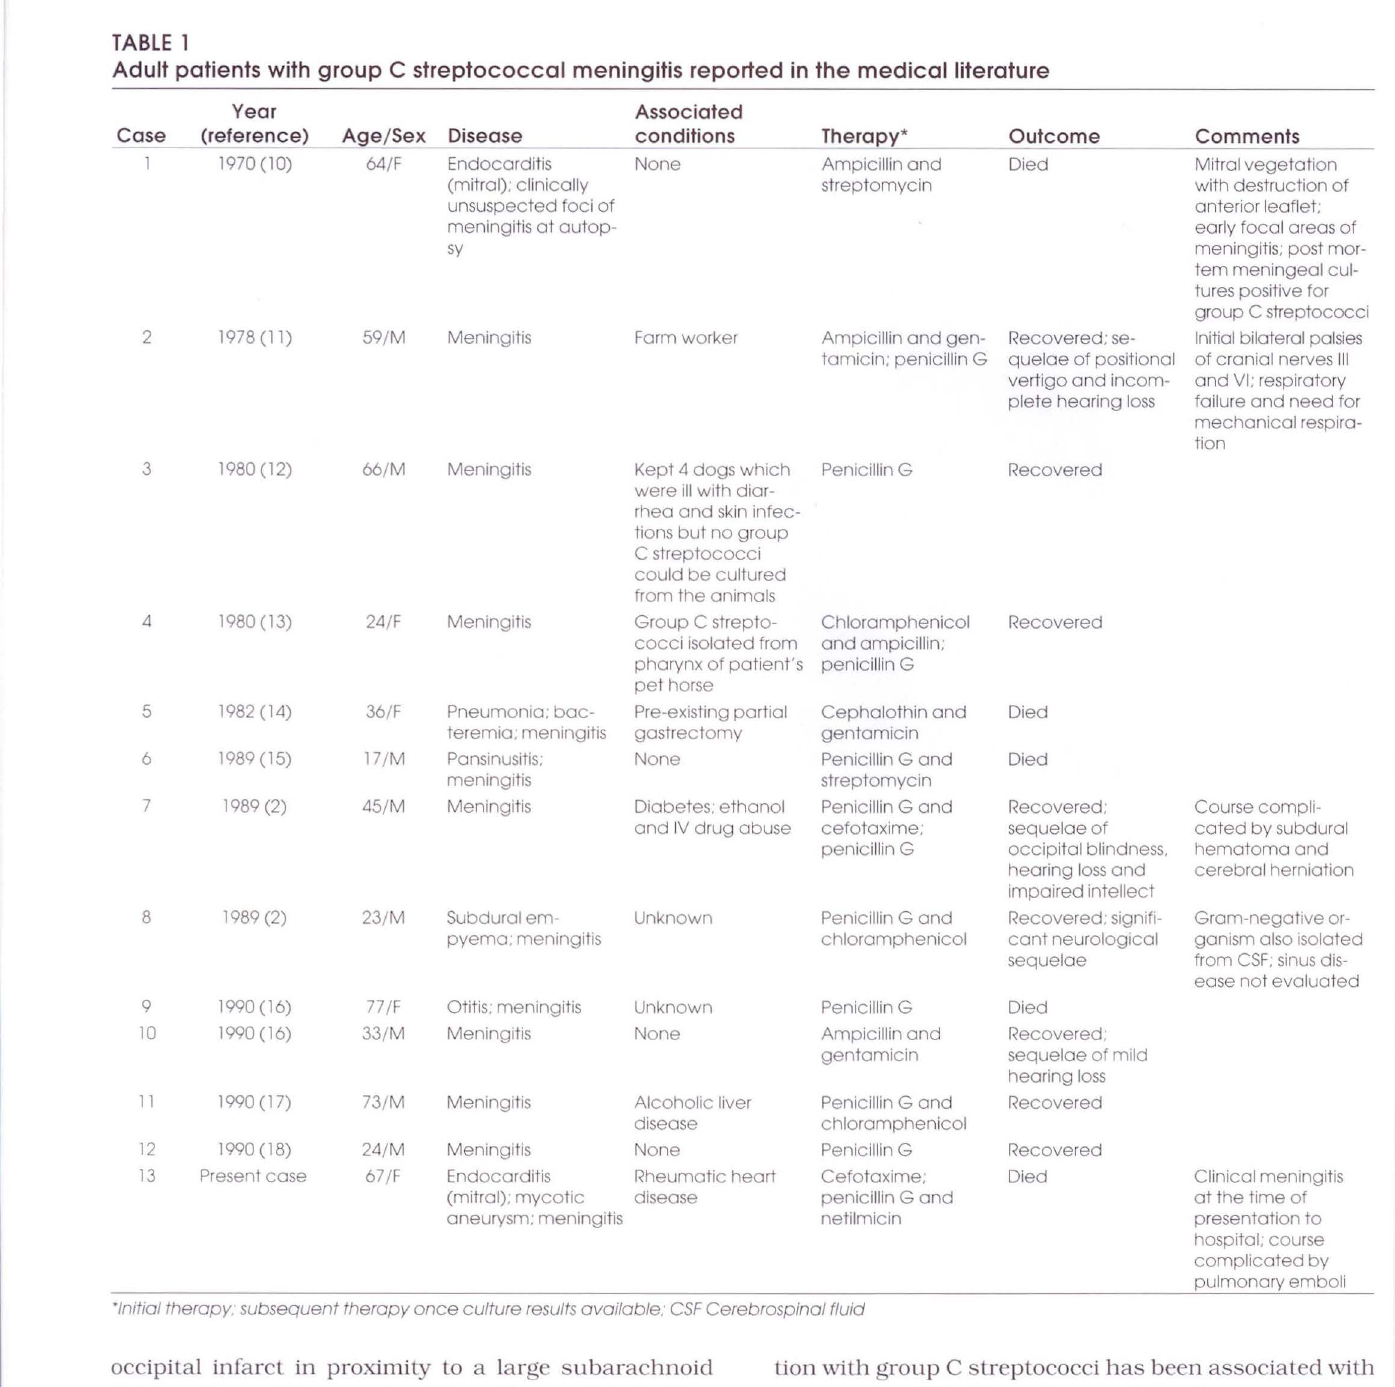
Adult patients with group C streptococcal meningitis reported in the medical